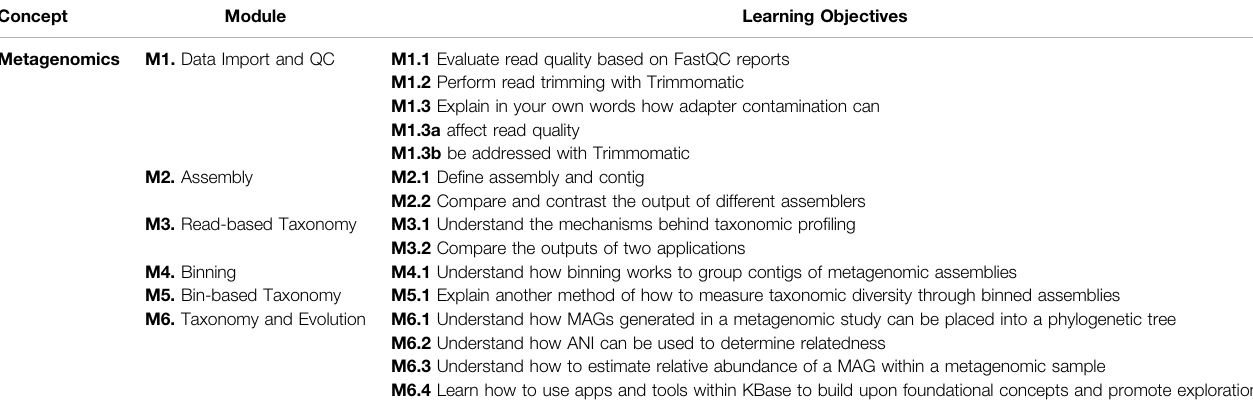
TABLE 2 | Example Concept Work fl ow in KBase using the Narrative on Metagenomics, including module topics and corresponding Learning